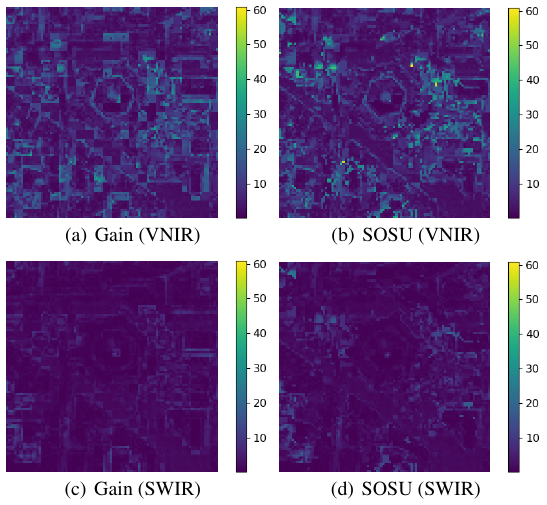
Figure 8. SAM error maps (in degrees) obtained in VNIR and SWIR for images fused by Gain and